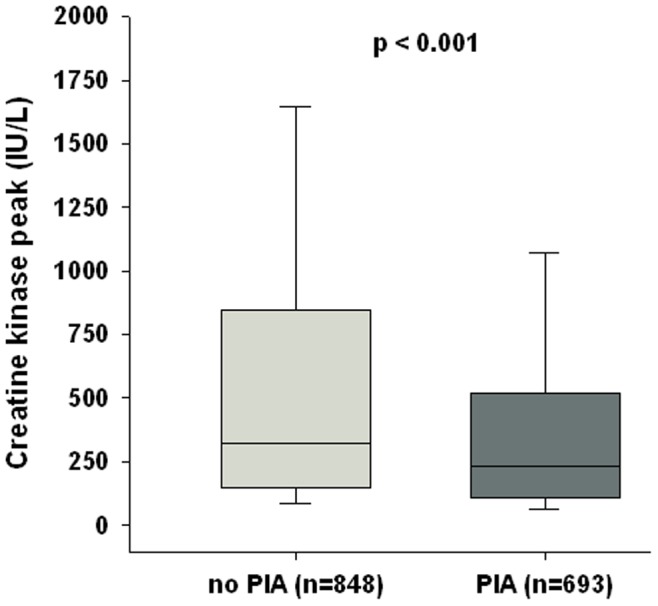
Levels of Creatine Kinase peak (IU/L) during the hospital phase.